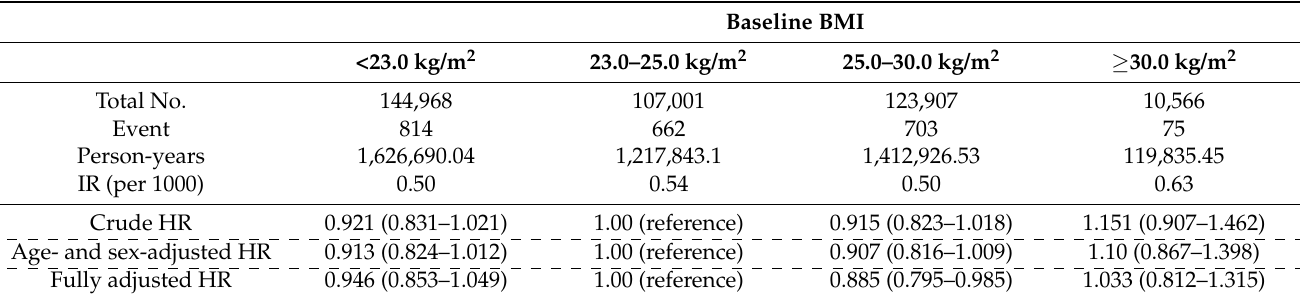
Table 2. Hazard ratios (HRs) and 95% confidence intervals (CIs) for the incidence of recurrent and persistent hematuria in glomerular disease according to body mass index (BMI)